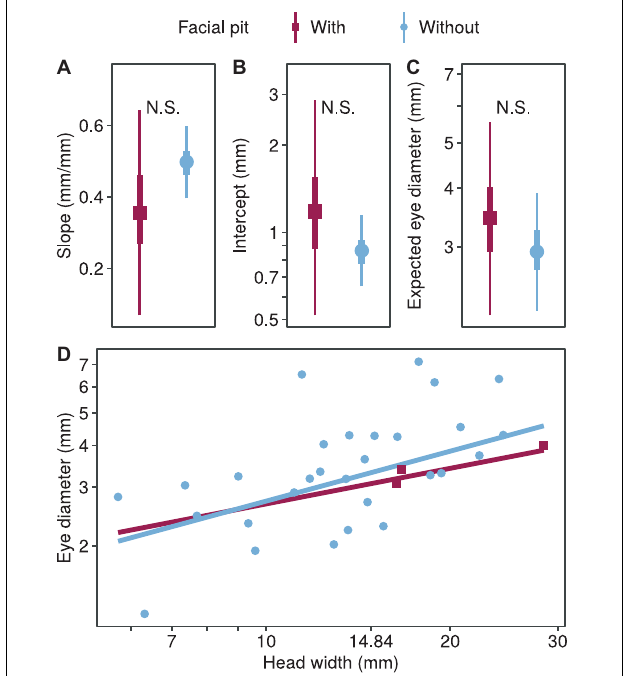
FIGURE 4 | Comparison of growth patterns of eye diameter and head width for different foraging modes, including allometric growth index (A) , scaling factor (B) , expected eye diameter (C) and scatter diagram (D) . In subplots (A–C) , the symbols, vertical thick lines and vertical thin lines indicate the median, 50 and 95% HDI of the posterior distribution, respectively, and lowercase letters indicate multiple comparisons between groups (not having the same letter indicates a significant difference), while N.S. indicates no statistical difference. In (D) , the points indicate the mean head width and eye diameter within each species.